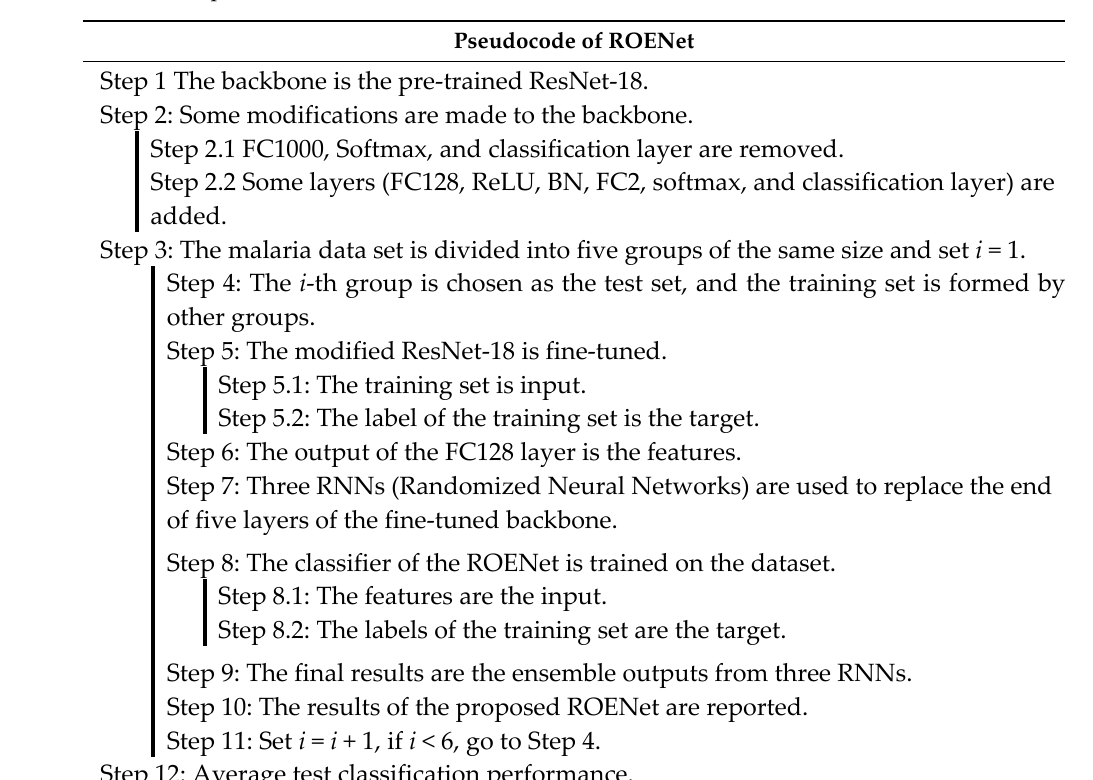
Table 2. The pseudocode of ROENet.